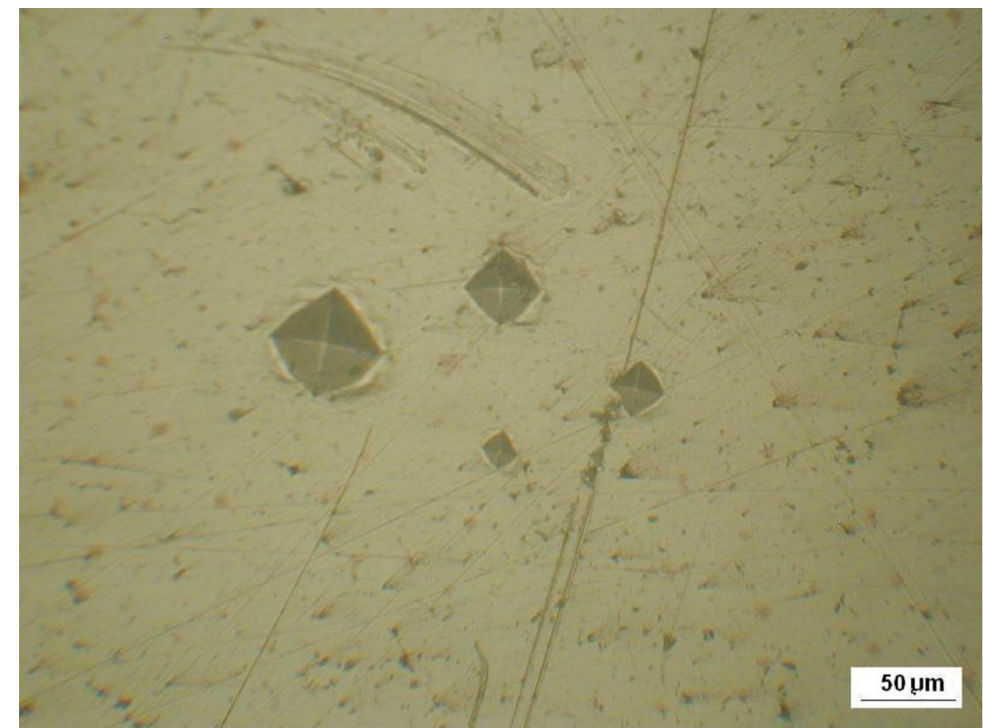
Figure 7. The arrangement of the indentations in the band, sample ε 10 . For the compressed samples, the values of the relative expanded uncertainty U rel of the micro-hardness range between 29.4% and 61.7%. Its value is overestimated by the used CRM (iron) with a micro-hardness significantly higher than the hardness of the measured samples. Therefore, these values should only be considered indicative. The relationship (correlation) between the degree of deformation ε , and the uncertainty is strong (r 2 = − 0.9049), and the uncertainty decreases with increasing deformation. The result of the micro-hardness measurement of compressed samples is “clusters” of 32–92 (depending on the degree of deformation) indentations for individual com- pressed samples. The average values of micro-hardness (HV) of each of the clusters, and the micro-hardness at individual loads are in Table 1 for the fractured tensile piece, and in Table 2 for compressed samples. The influence of the local reduction of the area, load, and micro-hardness for com- pressed samples are shown in Figure 8.